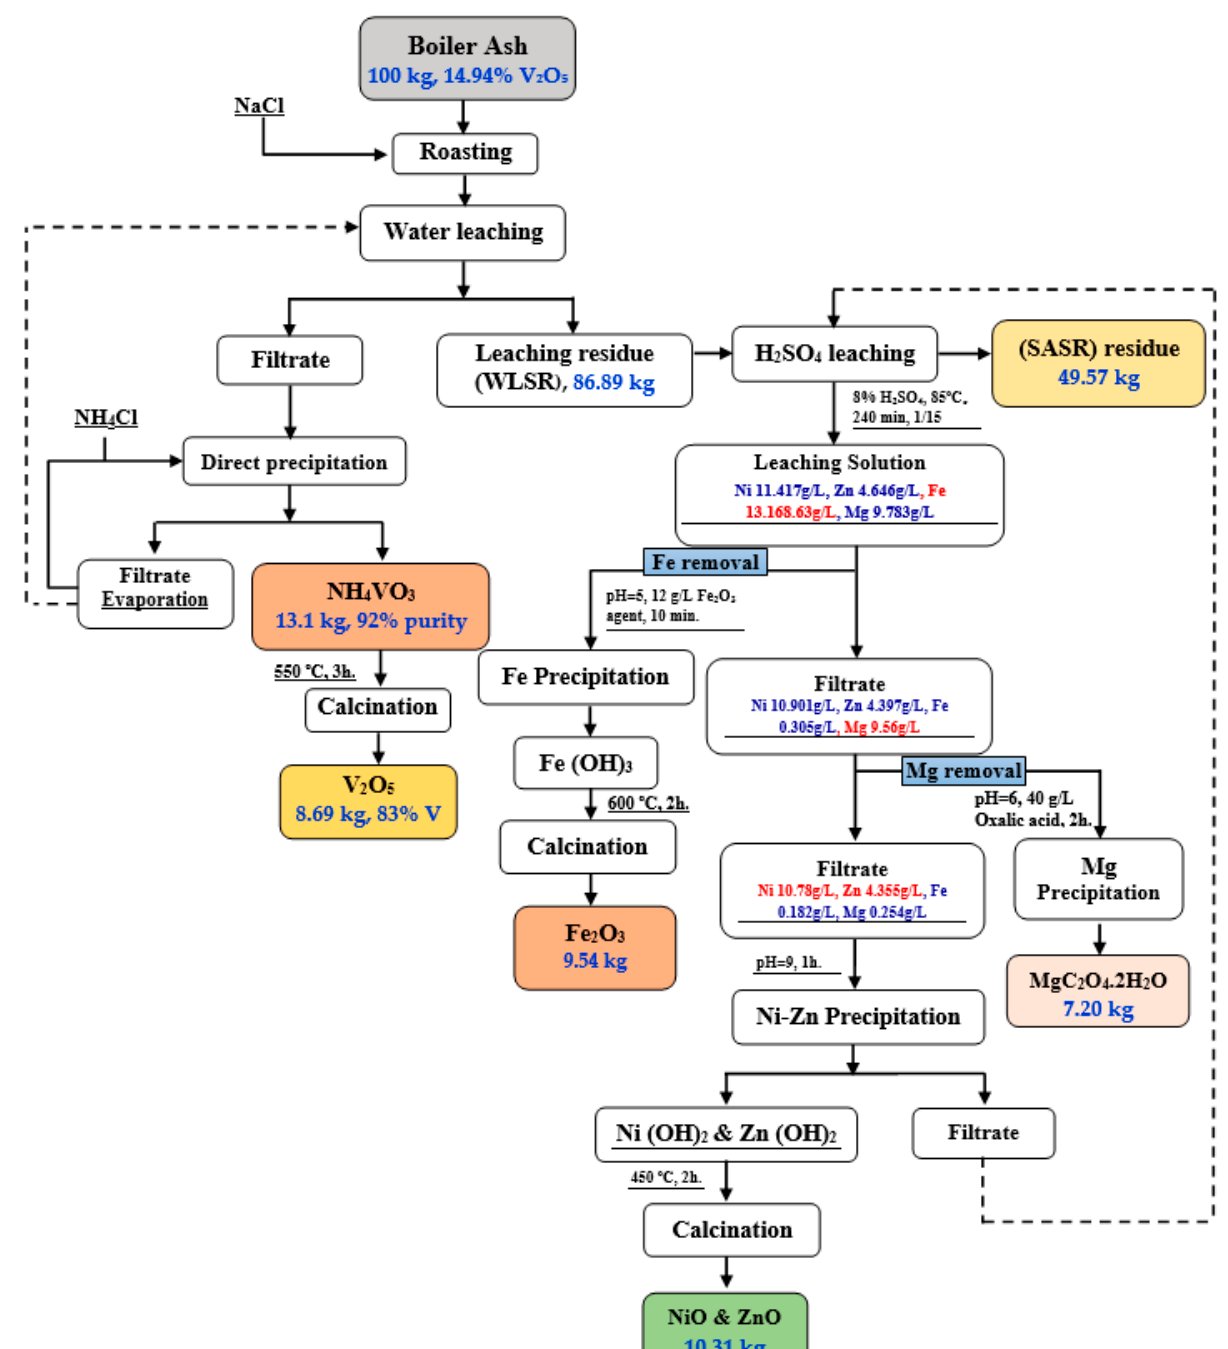
Figure 15. The proposed scheme for the recovery of Ni, Zn, Fe and Mg from water leaching solid residue obtained from the salt roasting of Egyptian boiler